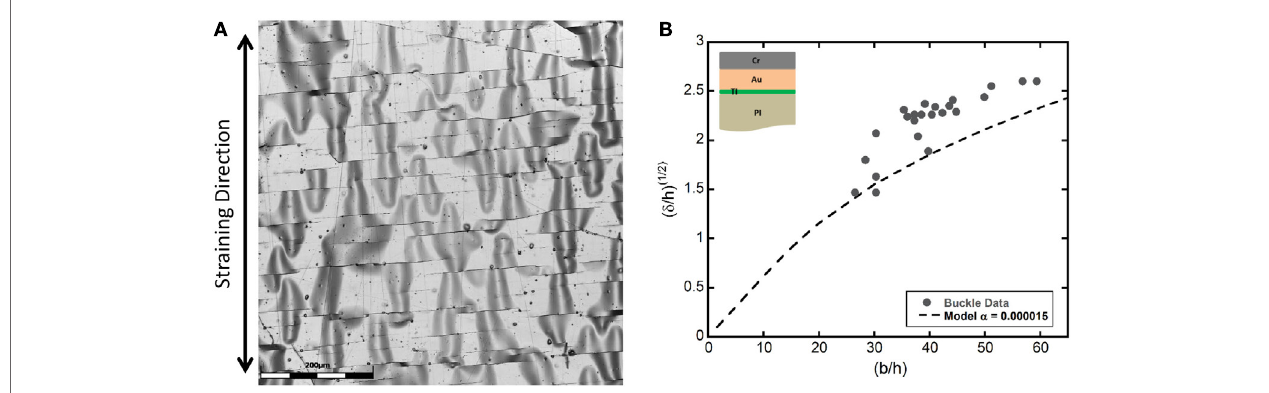
FigUre 8 | (a) CLSM laser image of the delaminated Cr/Au/Ti film from PI. (B) Using the tensile-induced delamination model and a minimum α -values of 0.00015, the adhesion energy was determined to be Γ = 1.9 ± 0.7 Jm − 2